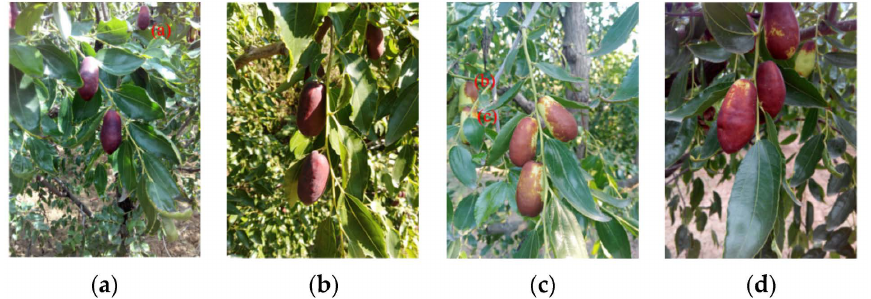
Figure 8. Original image of the Lingwu long jujube test. ( a ) Image with a small object; ( b ) Regular image; ( c ) Masked image; ( d ) Image of jujubes of different